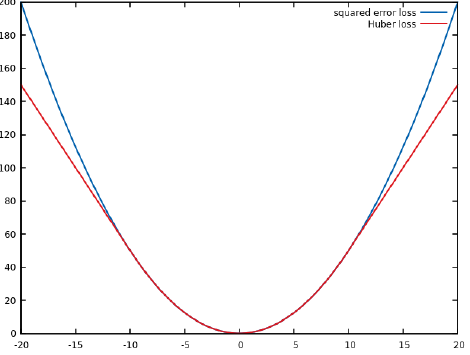
Figure 2. Comparison of the two loss functions, Huber and squared error, for δ = 10.